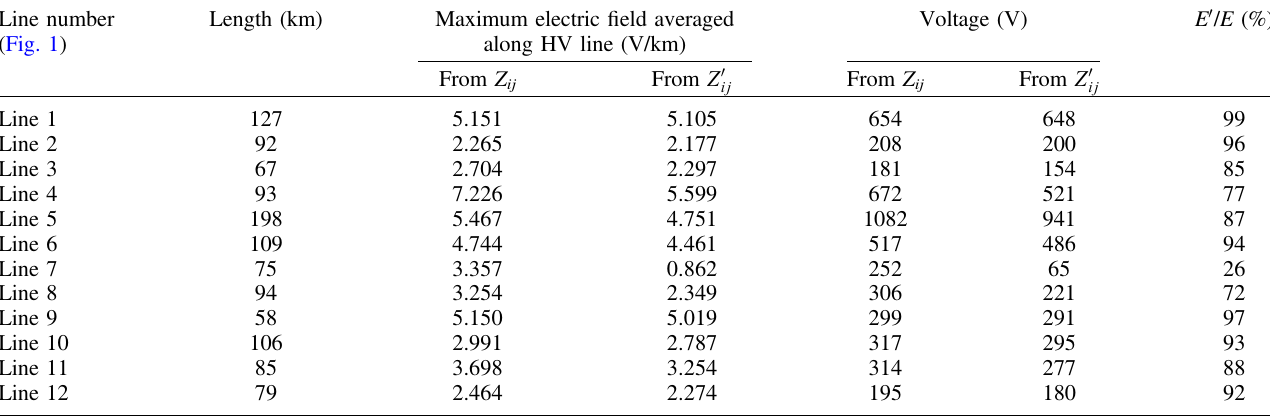
Table 1. Maximum peak-to-peak electric fi elds for the Halloween 2003 magnetic storm averaged (see Methods Sect. 2.2) in directions delineated by the 12 high-voltage (HV) transmission lines shown in Figure 1 and their associated transmission-line voltages. E 0 / E percentages are the magnitudes of quantities estimated using Z 0 relative to those estimated using Z ij . ij Line number (Fig.